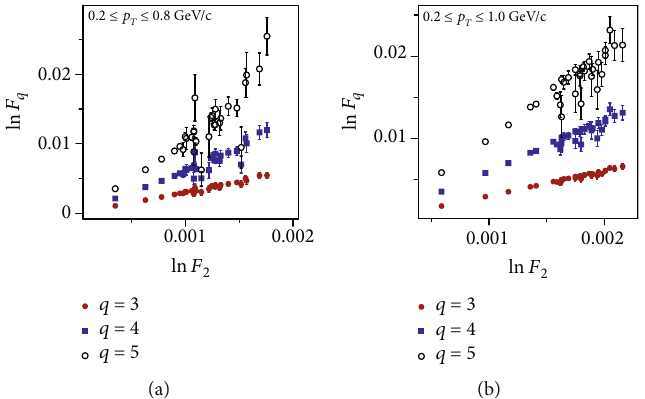
F 2 for EPOS3-hydro events for the